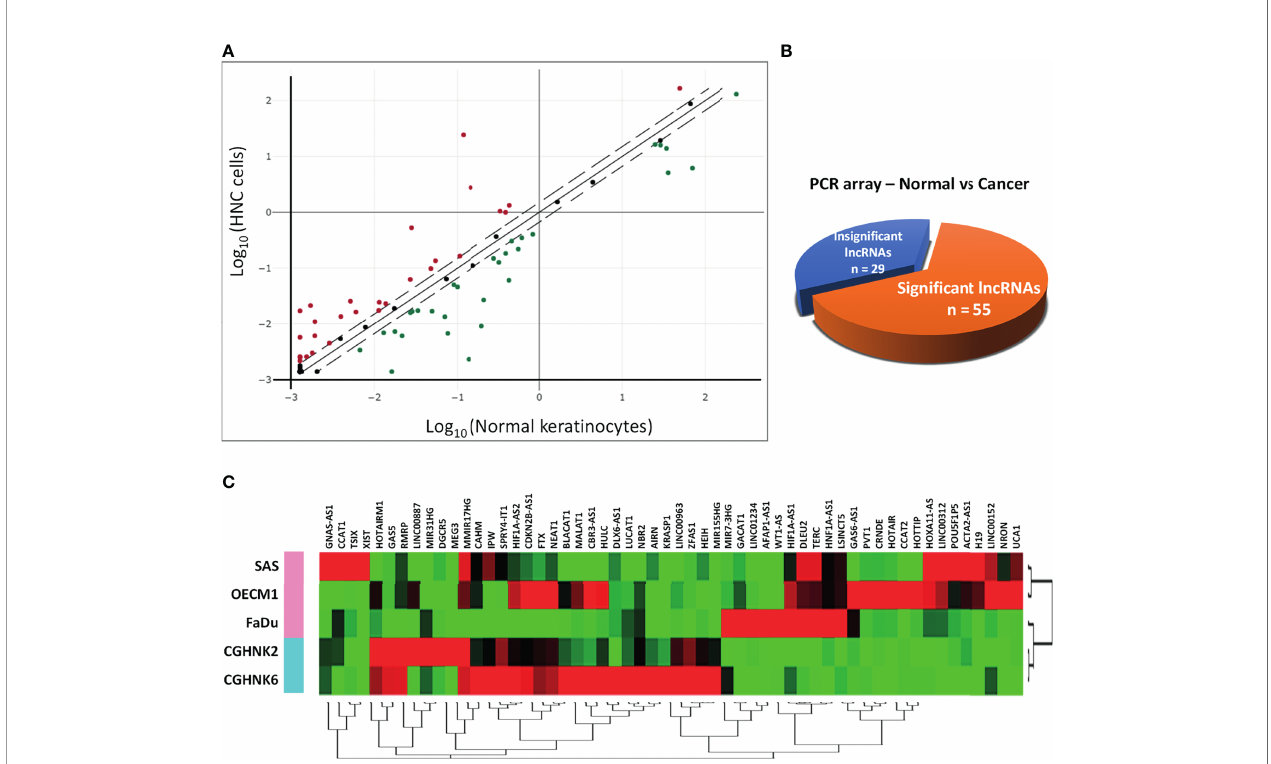
FIGURE 1 | Pro fi ling of 84 lncRNAs in three HNC cell lines (SAS, OECM1, FaDu) versus two normal keratinocyte cell lines (CGHNK2, CGHNK6) via lncRNA PCR Array. (A) Scatterplot of 84 lncRNAs. Dotted lines represent the selection criteria threshold of |FR| ≥ 1.5. Red dots represent upregulated lncRNAs (n = 27), and green dots represent downregulated lncRNAs (n = 28). Black dots represent insigni fi cant lncRNAs according to the selection criterion (n = 29). (B) Pie chart representation of the screening composition between signi fi cantly dysregulated lncRNAs (n = 55) and insigni fi cant lncRNAs (n = 29) in HNC, according to the PCR array results. (C) Clustergram of the 55 signi fi cantly dysregulated lncRNA expression pro fi les between the HNC and normal keratinocyte cell